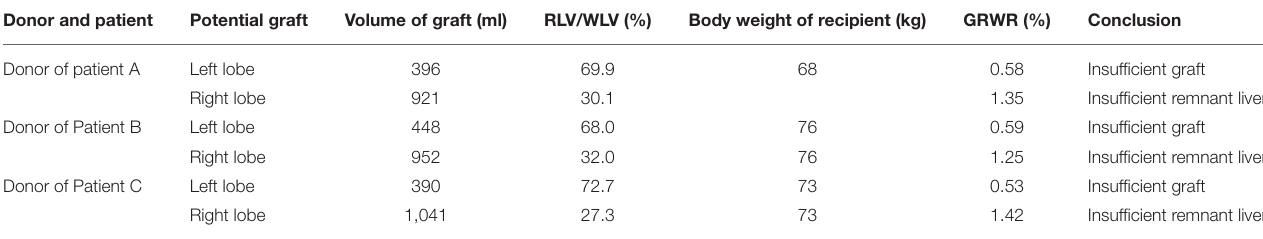
TABLE 1 | Volumetric assessment of left/right lobe of living donor by computerized tomography.